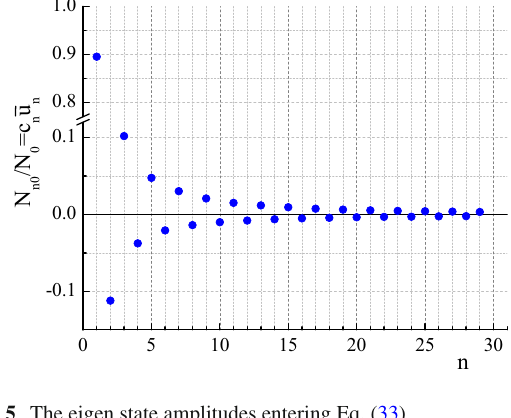
Fig. 5 The eigen state amplitudes entering Eq. (33)